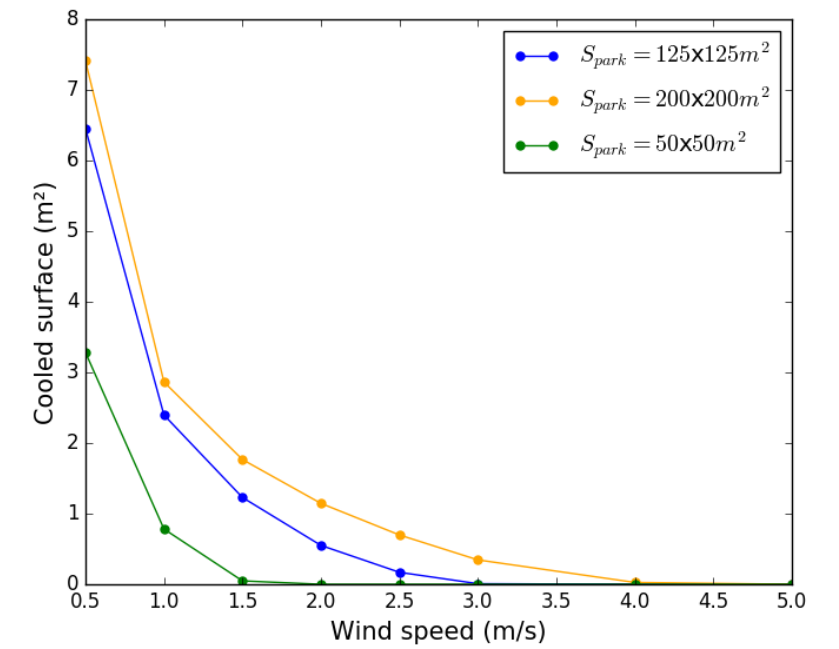
Figure 4. Cooled surface evolution with wind speed.